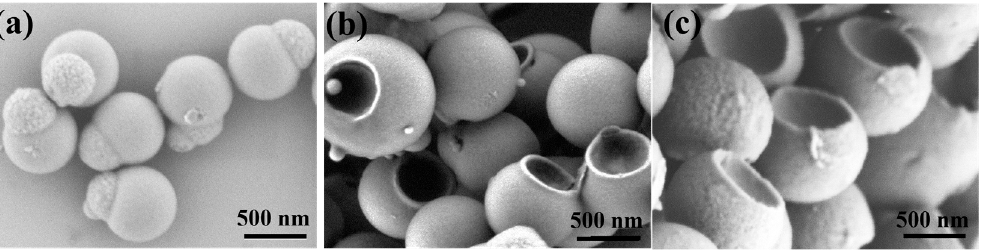
Figure 6. SEM images of ( a ) SiO 2 @MPSQ-AA particles, ( b ) MPSQ-AA bowl-shaped particles, and ( c ) bowl-shaped Janus particles. ( c ) bowl-shaped Janus